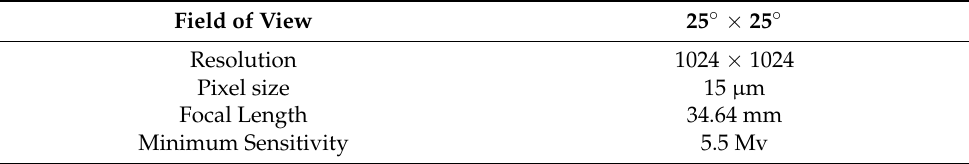
Table 1. Key parameters of sensor